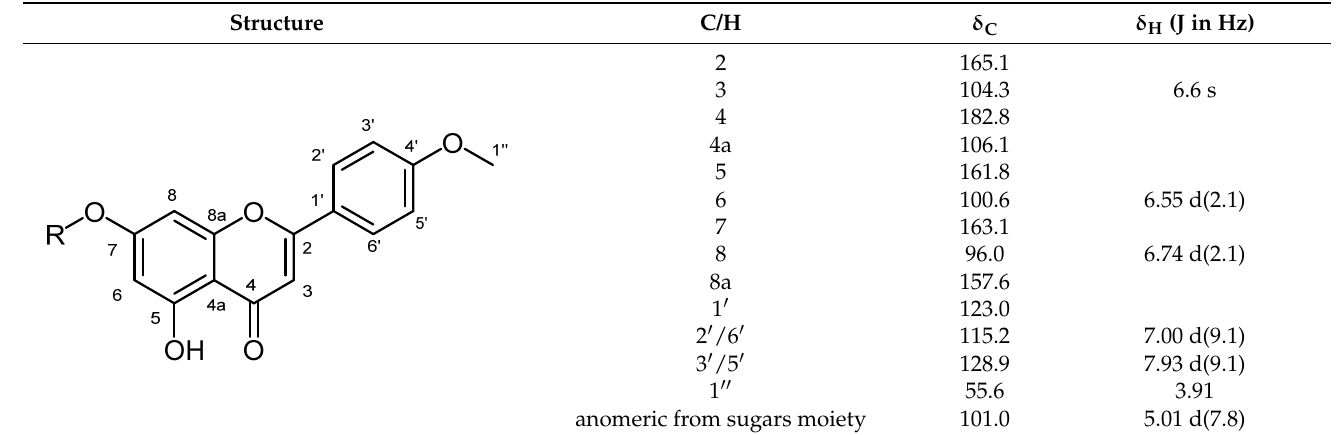
Table 1. Structure, 1 H and 13 C-NMR spectral data of acacetin-7- O -glycoside. Structure C/H δ C δ H (J in Hz)